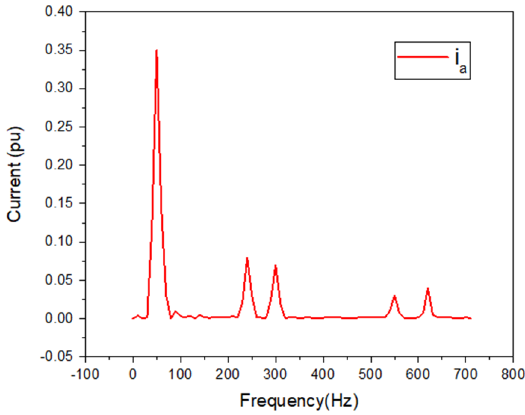
Figure 6. Fast Fourier transformation (FFT) analysis of the grid current.